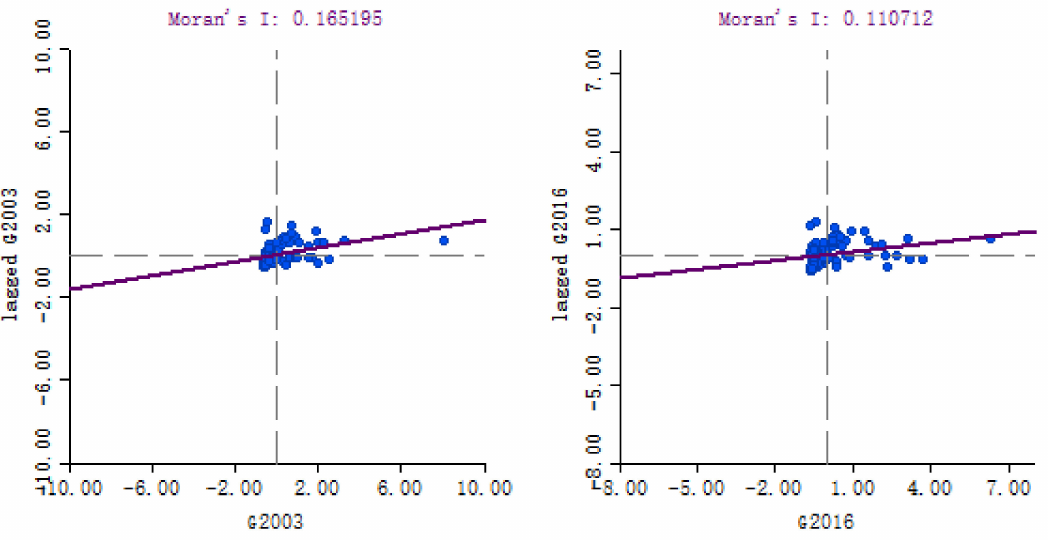
Figure 2. Local Moran scatter plots of the GDP of cities in the Yangtze River Economic Zone in 2003 and 2016. Source: Designed by